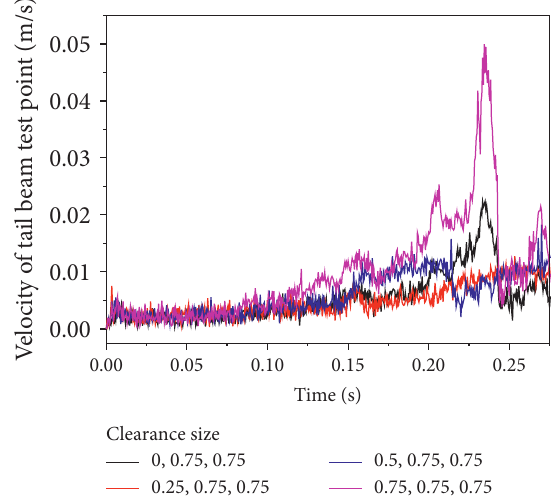
Figure 9: Stress of the test point of the pin shaft.